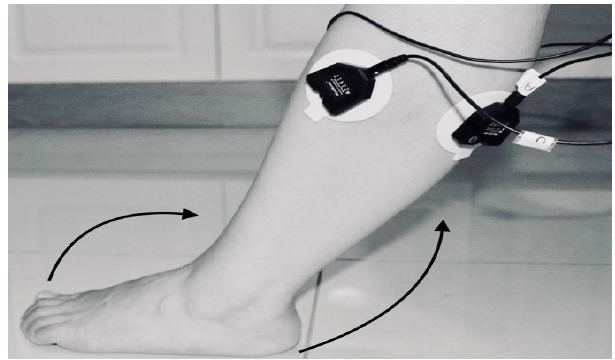
Figure 5. Knee Extension with Flexion Dorsiflexion.